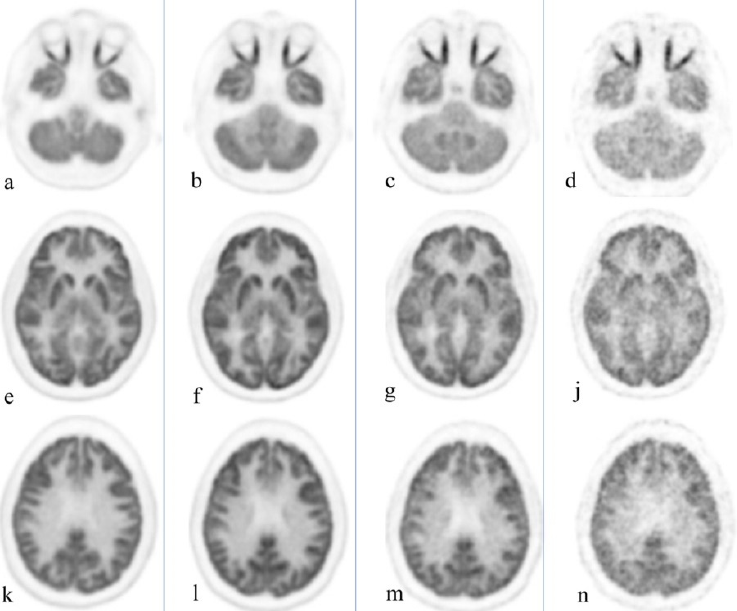
Figure 3. Healthy volunteer, total body PET/CT 20-min acquisition at 40 min, 3 h, 6 h, and 9 h after administration of 10 mCi of 18F-FGD. Cuts were selected at the orbit level ( a – d ), basal ganglia ( e – j ), and upper aspect of the ventricles ( k – n ). Brain uptake slowly decreases over time; the increase in noise level starts to become clinically evident at 9 h. Reprinted with permission from Ref. [4]. Cop- yright 2020 Elsevier.